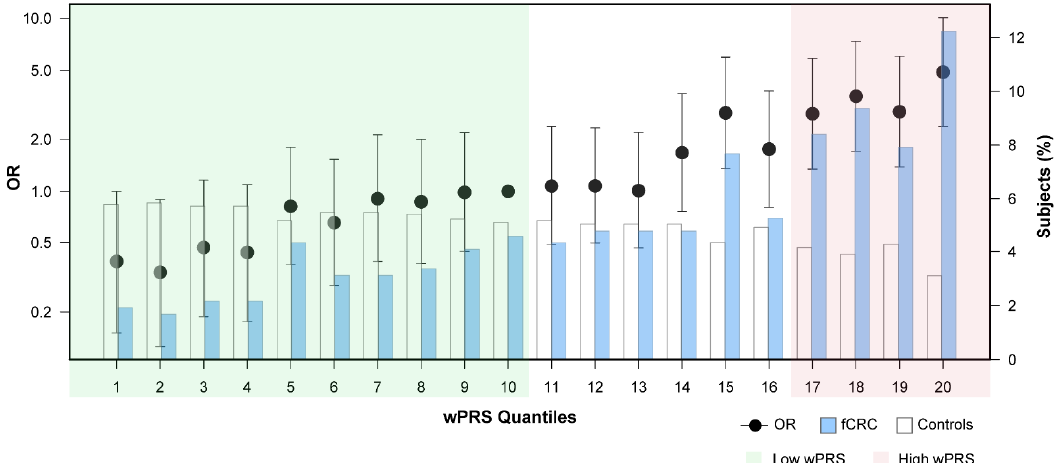
Figure 2. ORs (logarithmic scale) estimated for wPRS-quantile groups of fCRC patients and controls. wPRS quantiles (Q) contain near identical numbers of individuals (102–103 individuals/Q, including fCRC cases and controls). Blue and white bars represent the relative frequency of fCRC patients and controls, respectively. Q1 and Q20 contain individuals with the lowest and highest wPRS, respectively. Q10 (middle quartile) was considered the reference for OR calculations (OR = 1). Error bars indicate 95% confidence intervals. Shaded in green are low-wPRS quantiles (Q1–Q10) and, in red, high-wPRS quantiles (Q17–Q20). Abbreviations: OR, odds ratio; fCRC, familial/early-onset colorectal cancer; wPRS, weighted PRS. Table 3. Characteristics of high-wPRS fCRC patients (quantiles 17–20; Figure 2) compared to those with low wPRS (quantiles 1–10; Figure 2). In bold, statistically significant results.